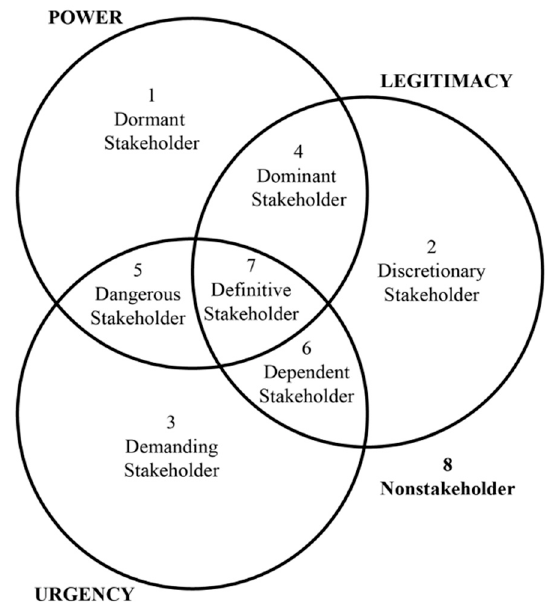
Figure 1. Stakeholder typology adapted from Mitchell et al. (1997).